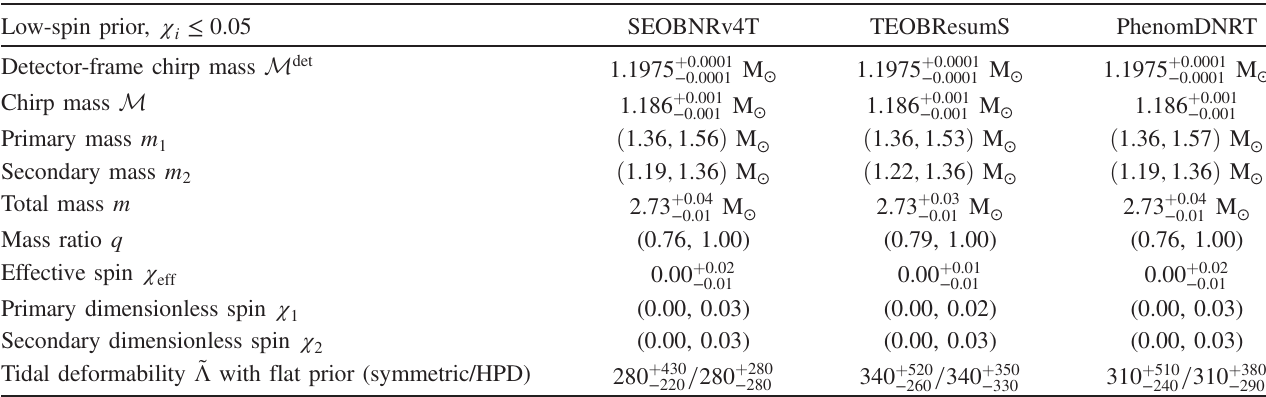
TABLE V. Source properties for GW170817 produced using R APID PE for the additional waveform models SEOBNRv4T and TEOBResumS. Conventions are the same as in Table